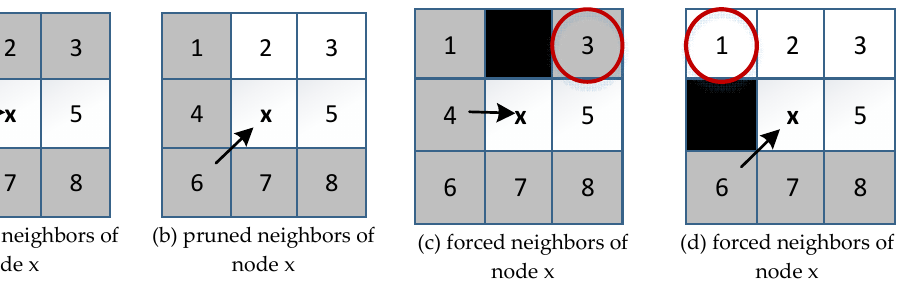
Figure 9. Neighbor Pruning and Forced Neighbor.